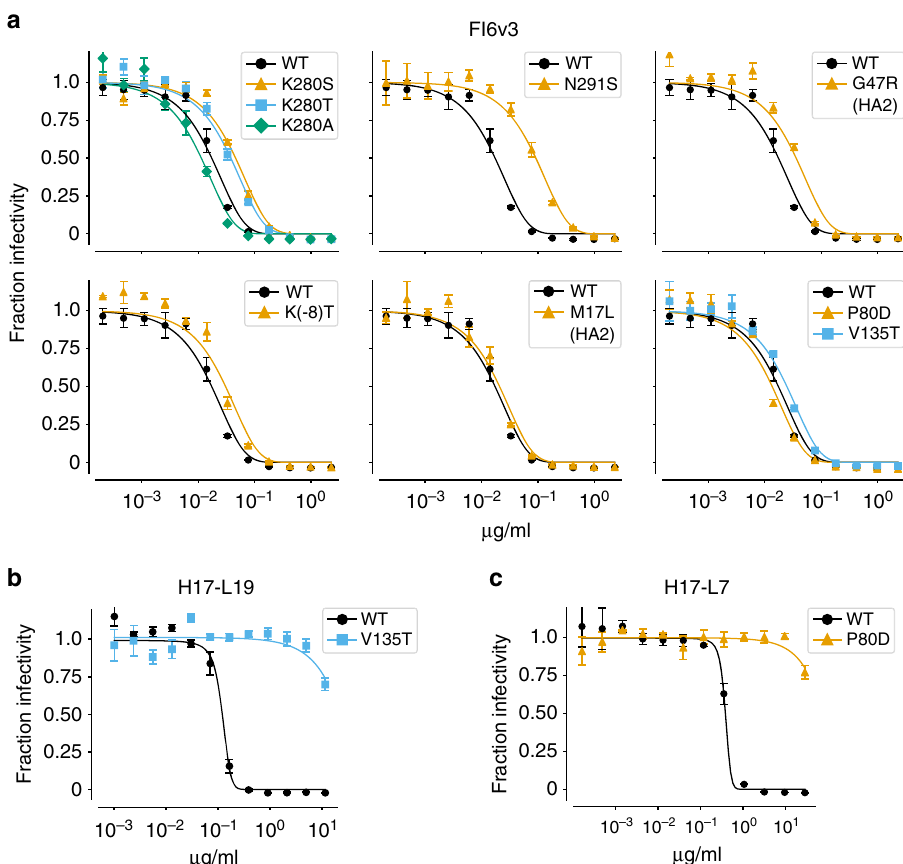
Fig. 6 The mutations selected by FI6v3 increase neutralization resistance, but the effects are small. a Neutralization curves of individual viral mutants with FI6v3. The mutations K280S, K280T, N291S, G47R (HA2), and K(-8)T are all expected to increase neutralization resistance based on the mutational antigenic pro fi ling (Fig. 5a), whereas K280A, M17L (HA2), P80D, and V135T are not expected to affect neutralization (Supplementary Fig 6). All neutralization curves in this panel were performed in triplicate on the same day. This panel shows the average of the replicates; Supplementary Fig. 9 shows the curves for each replicate individually and performs statistical testing of whether the IC50s for mutants are signi fi cantly different than for wildtype. b , c In contrast to FI6v3, mutations selected by narrow antibodies have very large effects on neutralization. Neutralization curves for representative escape mutants from H17-L19 and H17-L7 taken from Doud et al. 47 are shown. Points indicate mean and standard error of three